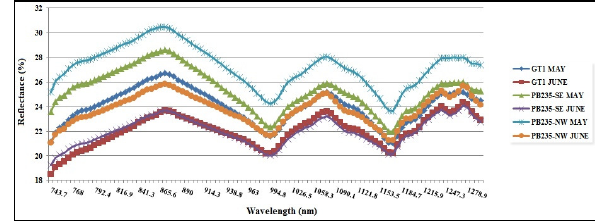
Figure 10. Spectral behaviour in canopy scale from 740 to 1,300nm, for May and June, of the Rubber trees stands: GT1, PB235-SE and PB235-NW